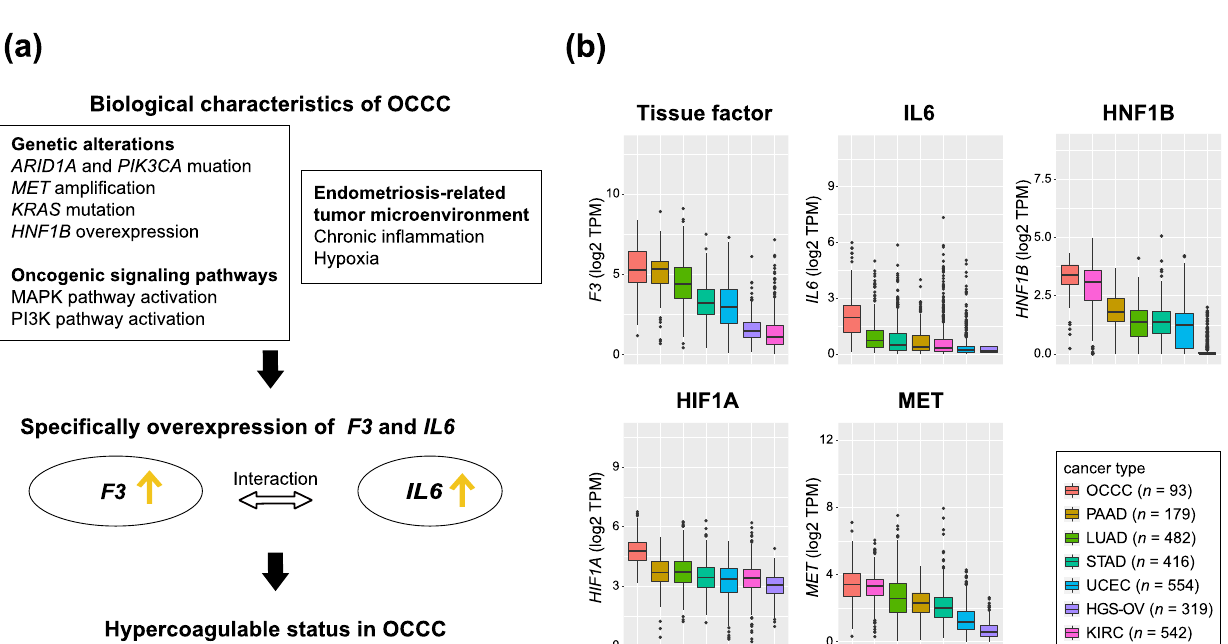
Figure 1. Biological factors that induce hypercoagulation in OCCC. ( a ) The correlation between biological characteristics of OCCC and hypercoagulable status in OCCC ( b ) Box plots showing the log2 TPM of representative key genes that induce hypercoagulation in 93 OCCCs and 2492 pan- cancers. OCCC is shown on the far left. Other cancers are sorted in order to increase log2 TPM. OCCC: ovarian clear cell carcinoma, PAAD: pancreatic adenocarcinoma, KIRC: kidney renal cell carcinoma, LUAD: lung adenocarcinoma, STAD: stomach adenocarcinoma, HGS-OV: high-grade serous ovarian cancer, UCEC: uterine corpus endometrial carcinoma. Gene expression data were retrieved from our previous study [21] .